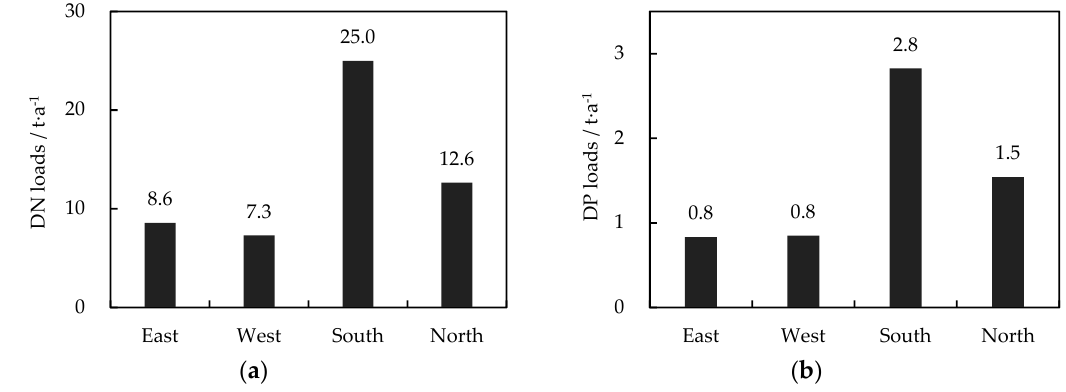
Figure 7. ( a ) DN and ( b ) DP loads discharged into Lake Chenghai from the different regions surrounding the lake. Table 3. DN and DP loads discharged into Lake Chenghai from the different land-use types.